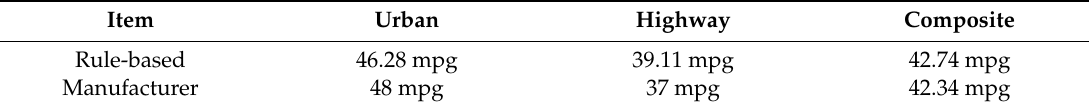
Table 2. Vehicle parameters.